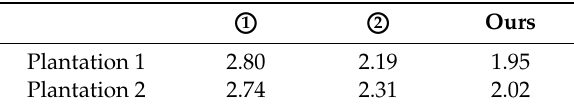
Table 5. Comparison of the t -test values of the three methods for the two forest plantations. 1 (cid:79) denotes the method based on point cloud automatic classification, 2 (cid:79) denotes the proposed method without the contour-surround